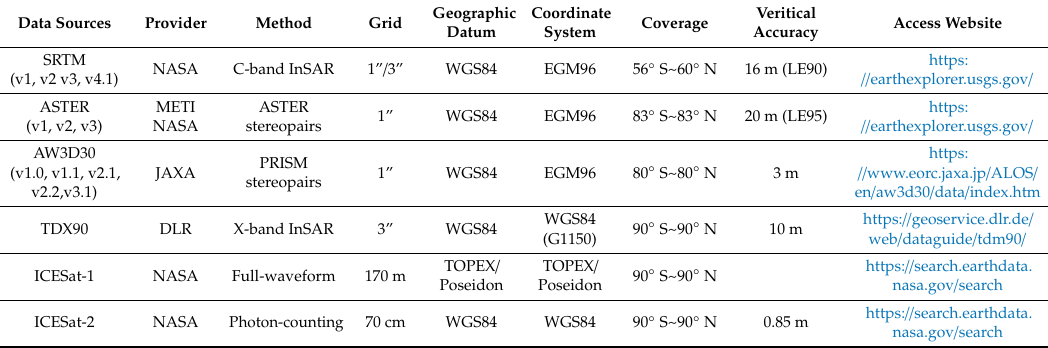
Table A1. Summary of the selected DEM